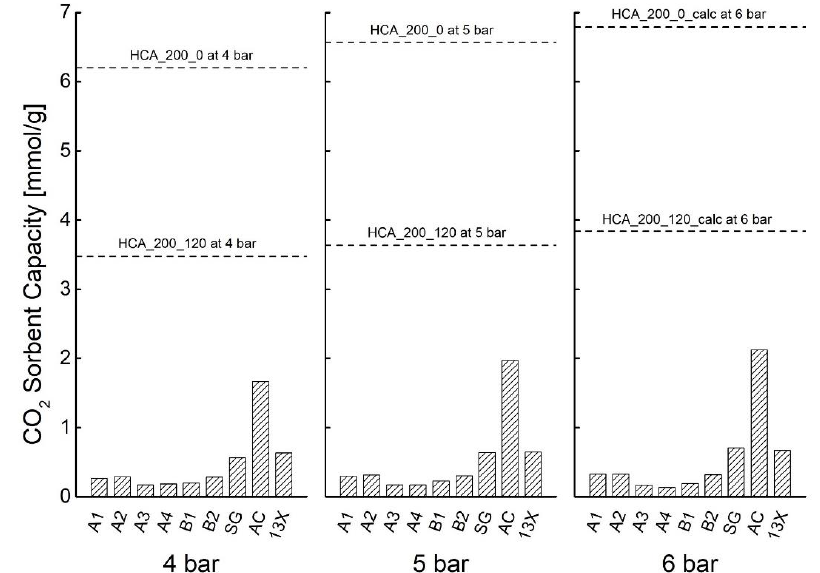
Figure 7. Comparison of CO 2 sorbent capacities with literature data obtained with the dynamic experimental method (pressure swing adsorption (PSA)) (A1, A2, A3, A4, B1, B2: zeolites from fly ash; SG: commercial silica gel; AC: commercial activated carbon; 13X: commercial zeolite [22]).